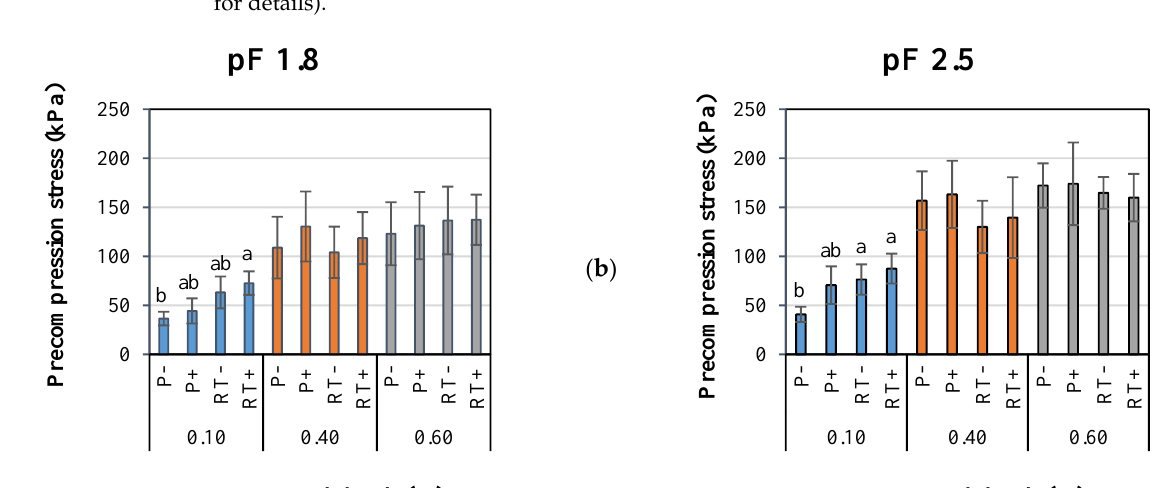
Figure 4. Mean precompression stress according to the different treatments and depths at ( a ) pF 1.8 and ( b ) pF 2.5. P: plow, RT: reduced tillage, +/ − : with and without compost, ± standard deviation. a and b, significant differences according to the ANOVA and Tukey-test ( b ) and Welch-ANOVA ( a